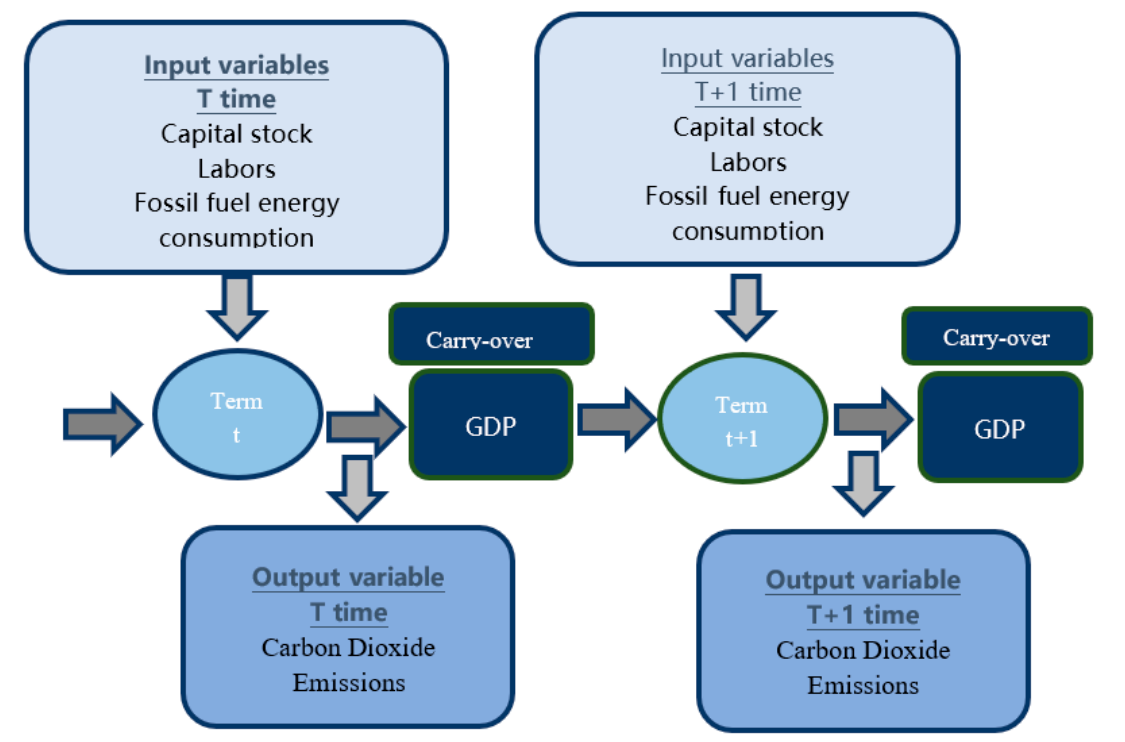
Figure 1. The details of the dynamic DEA model.